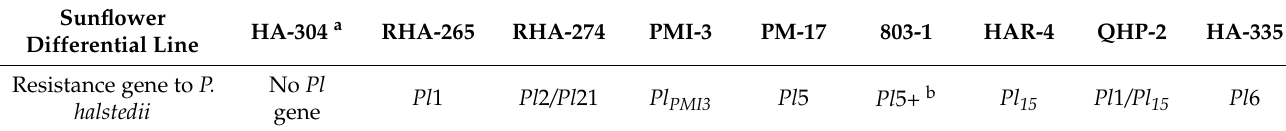
Table 2. Sunflower differential lines with different resistance genes used in the experiment for pathotype characterization of Plasmopara halstedii (based on Gascuel et al. [2], Trojanov á et al. [23], and Gulya et al. [25]). Sunflower Differential Line Resistance gene to P.